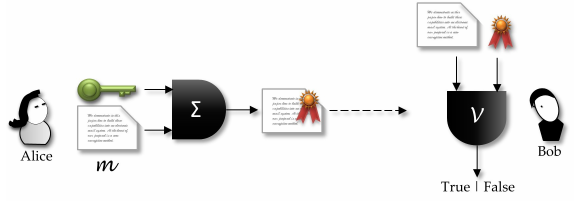
Figure 1. Signature of a message m by the sender, and the verification process by the